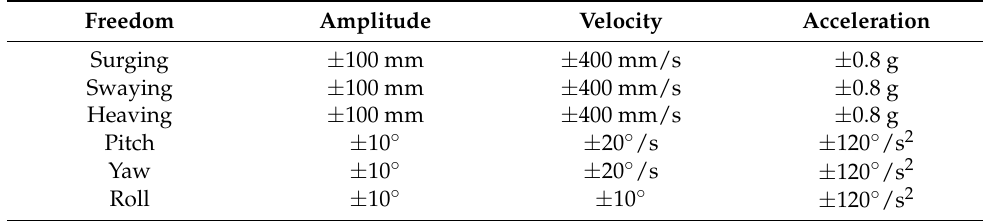
Table 6. Motion Parameters of the Six-degrees-of-freedom Motion Platform.